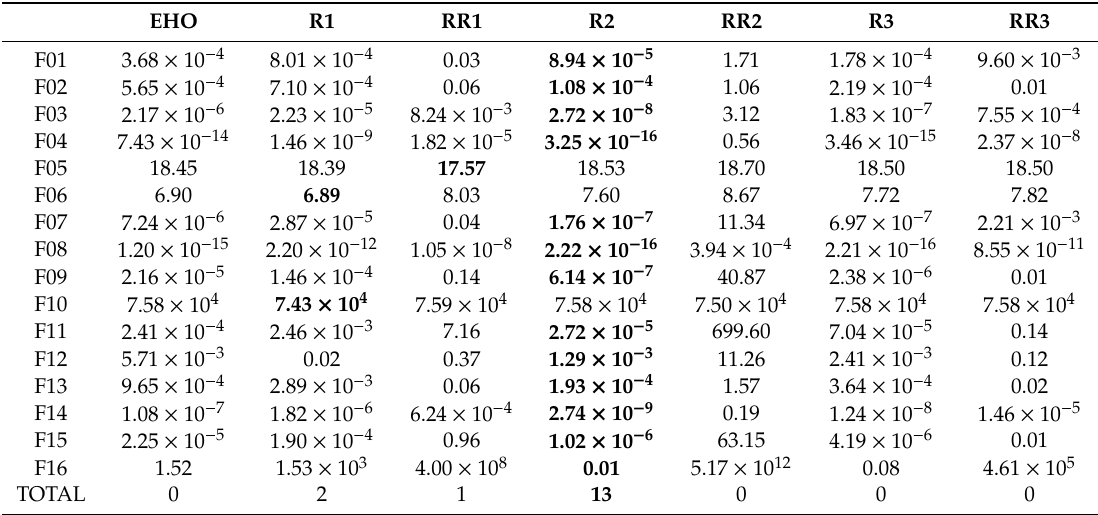
Table 6. Mean function values obtained by EHO and six improved methods with D = 200.